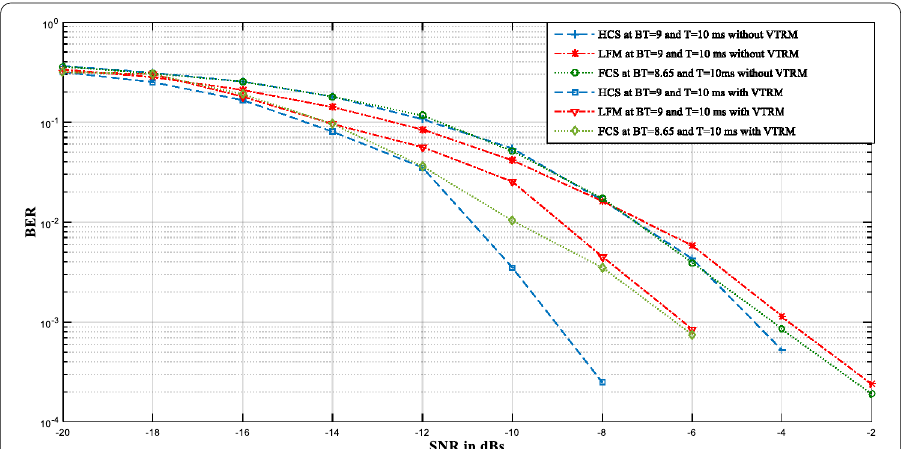
Fig. 11 BER versus SNR graph of HCS Chirp, FCS Chirp and LFM with SF 9sHz and 8.65, respectively, and Chirp Period 10 ms